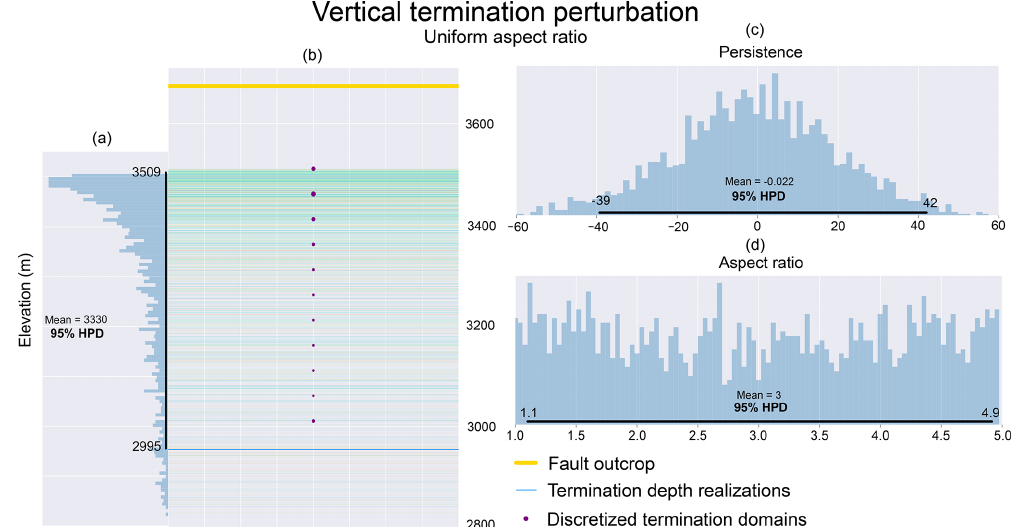
Figure 6. Visualization of Monte Carlo samples and associated geologic input realizations from perturbation of the fault zone vertical termination depth based on a uniform distribution of fault aspect ratio. The 95% highest predictive density is overlain on the histograms of the Monte Carlo samples.